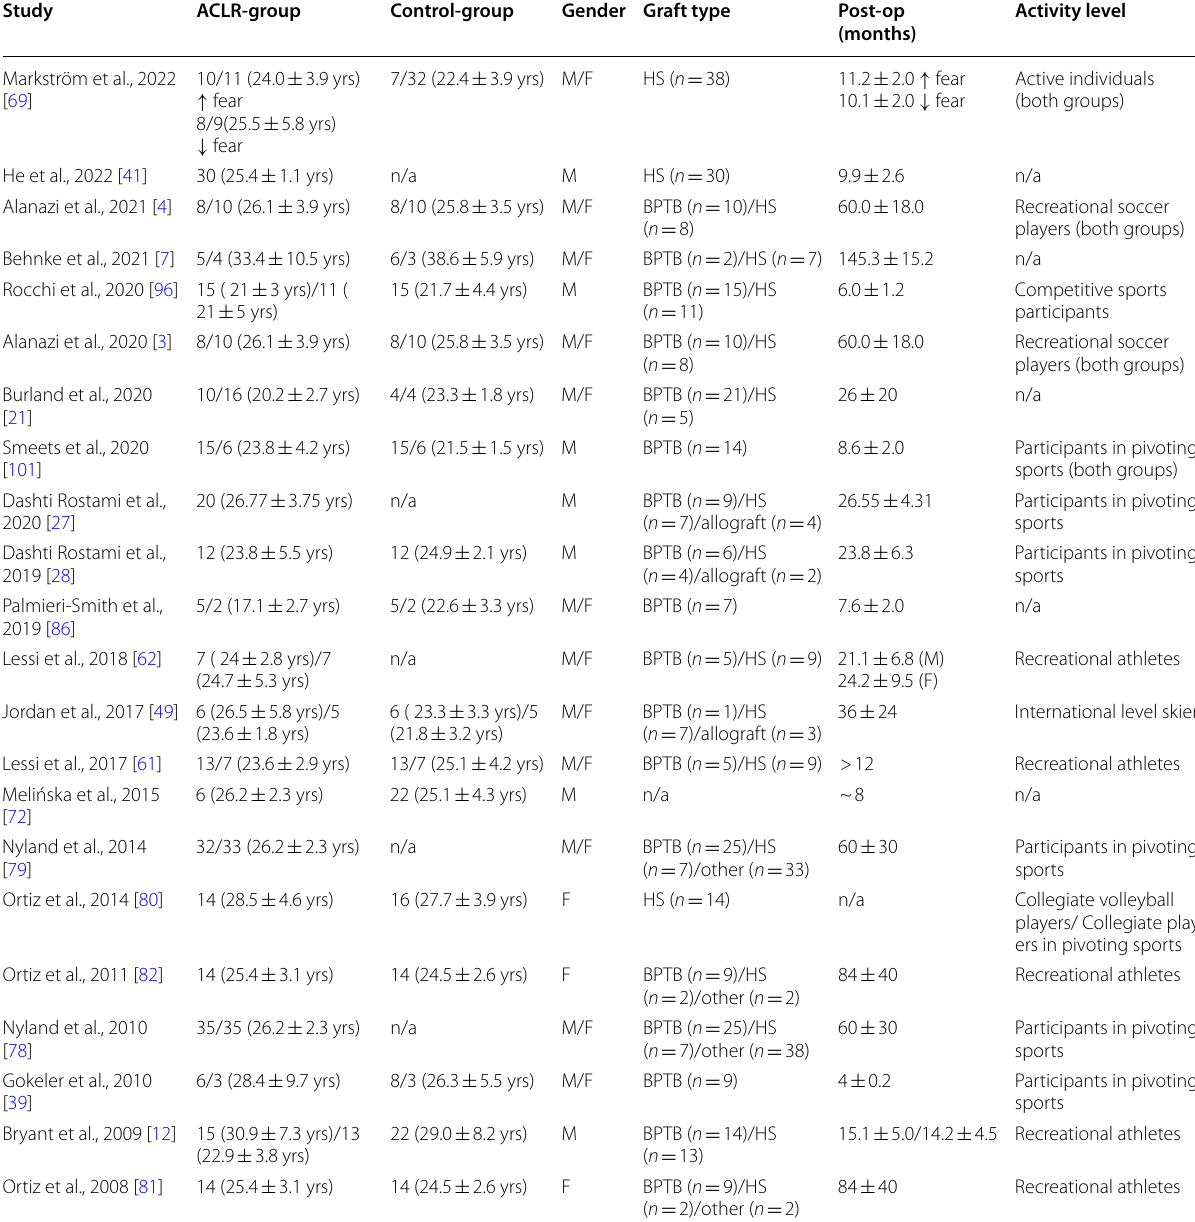
Table 2 Participants characteristics for electromyographic jumping/landing